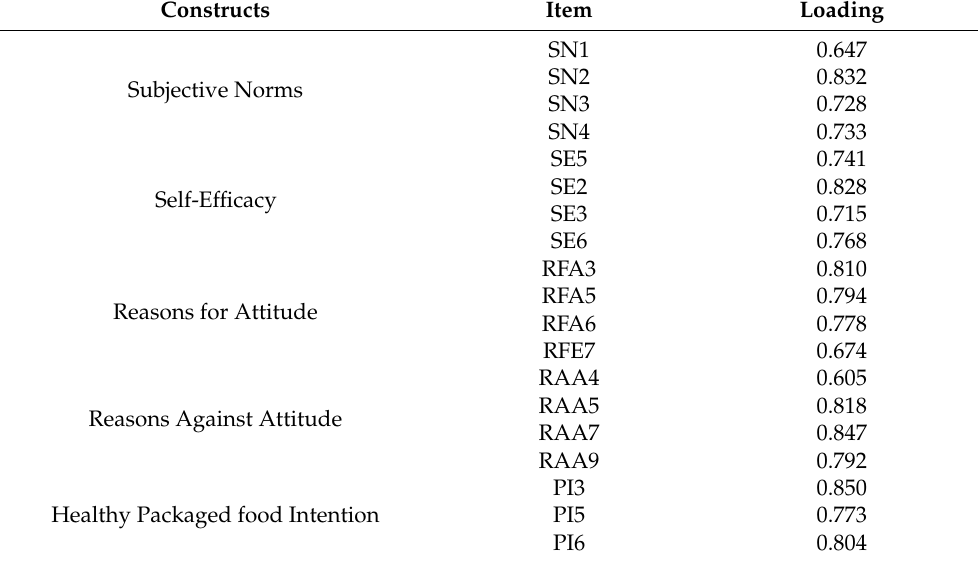
Table 3. Factors